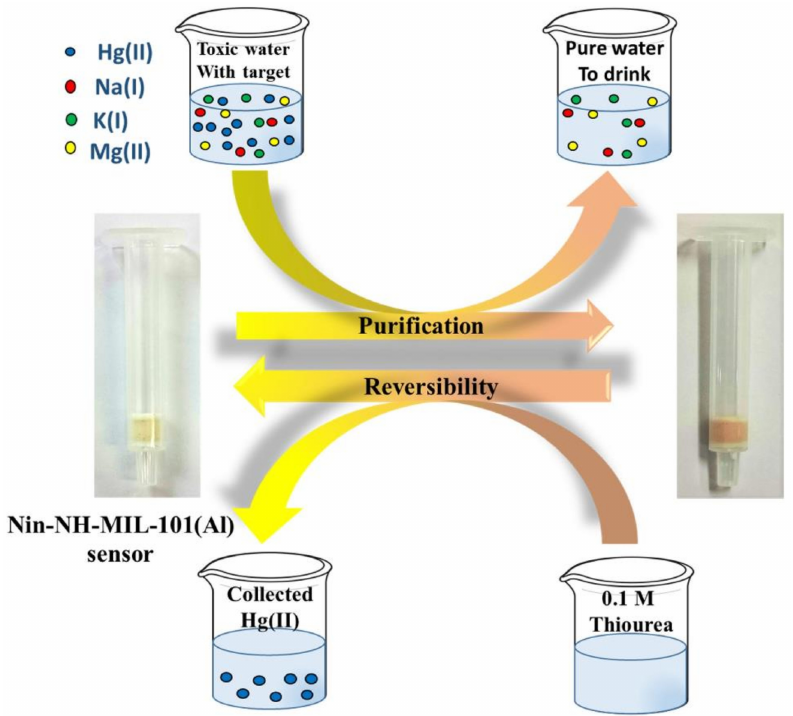
Figure 15. Representative design of the Nin-NH-MIL-101(Al) sensor applied to purification of water polluted with Hg(II) ions and the reversible process by using 0.1 M thiourea solution for several times (reproduced with the permission from Ref